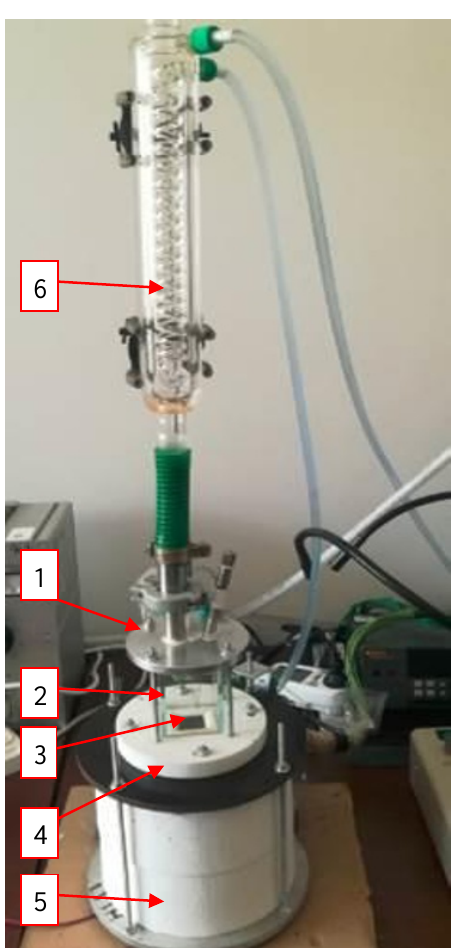
Fig. 2. Main module; 1 – top flange, 2 – glass vessel, 3 – sample, 4 – teflon annular flange, 5 – insulation, 6 –